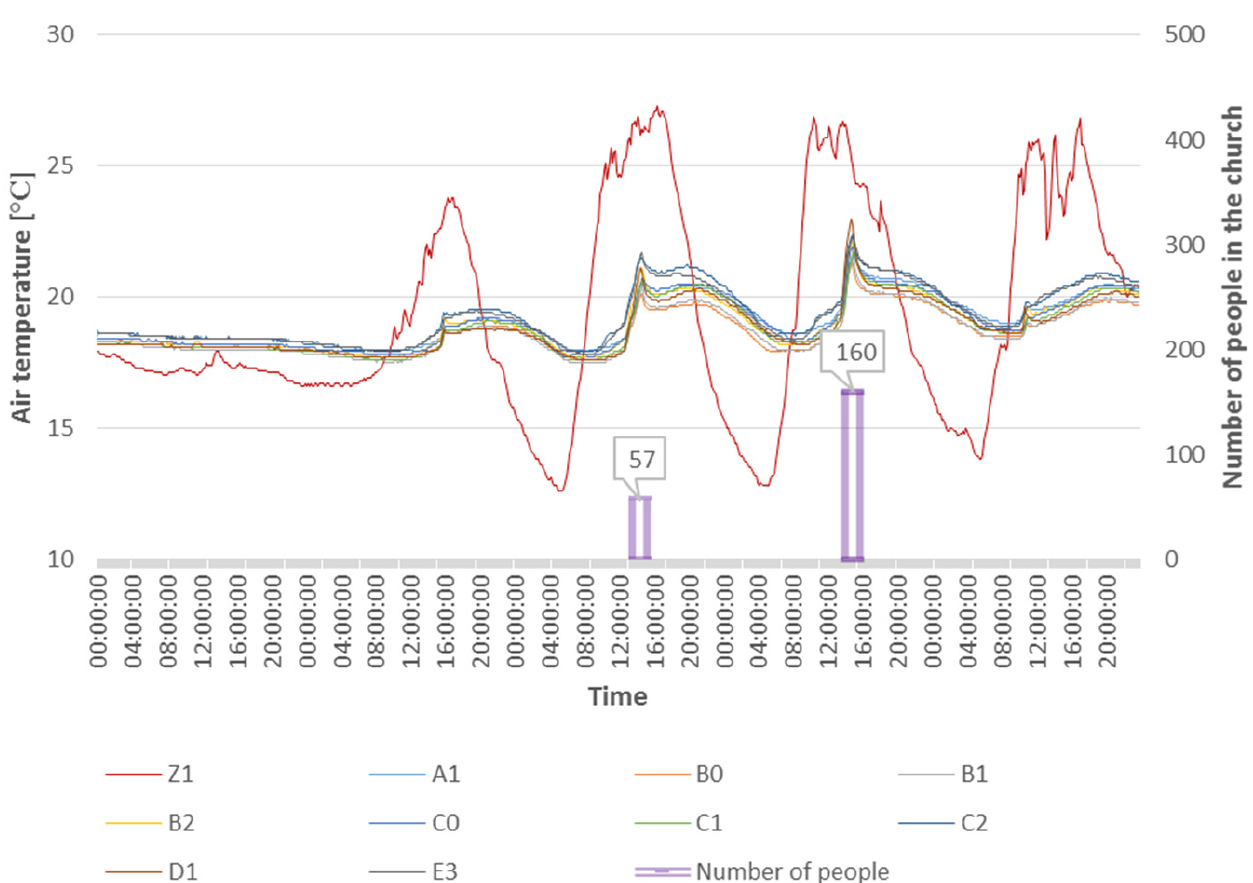
Figure 5. The course of air temperature and relative humidity inside and outside the building, during the summer period (19 July–23 July 2018).